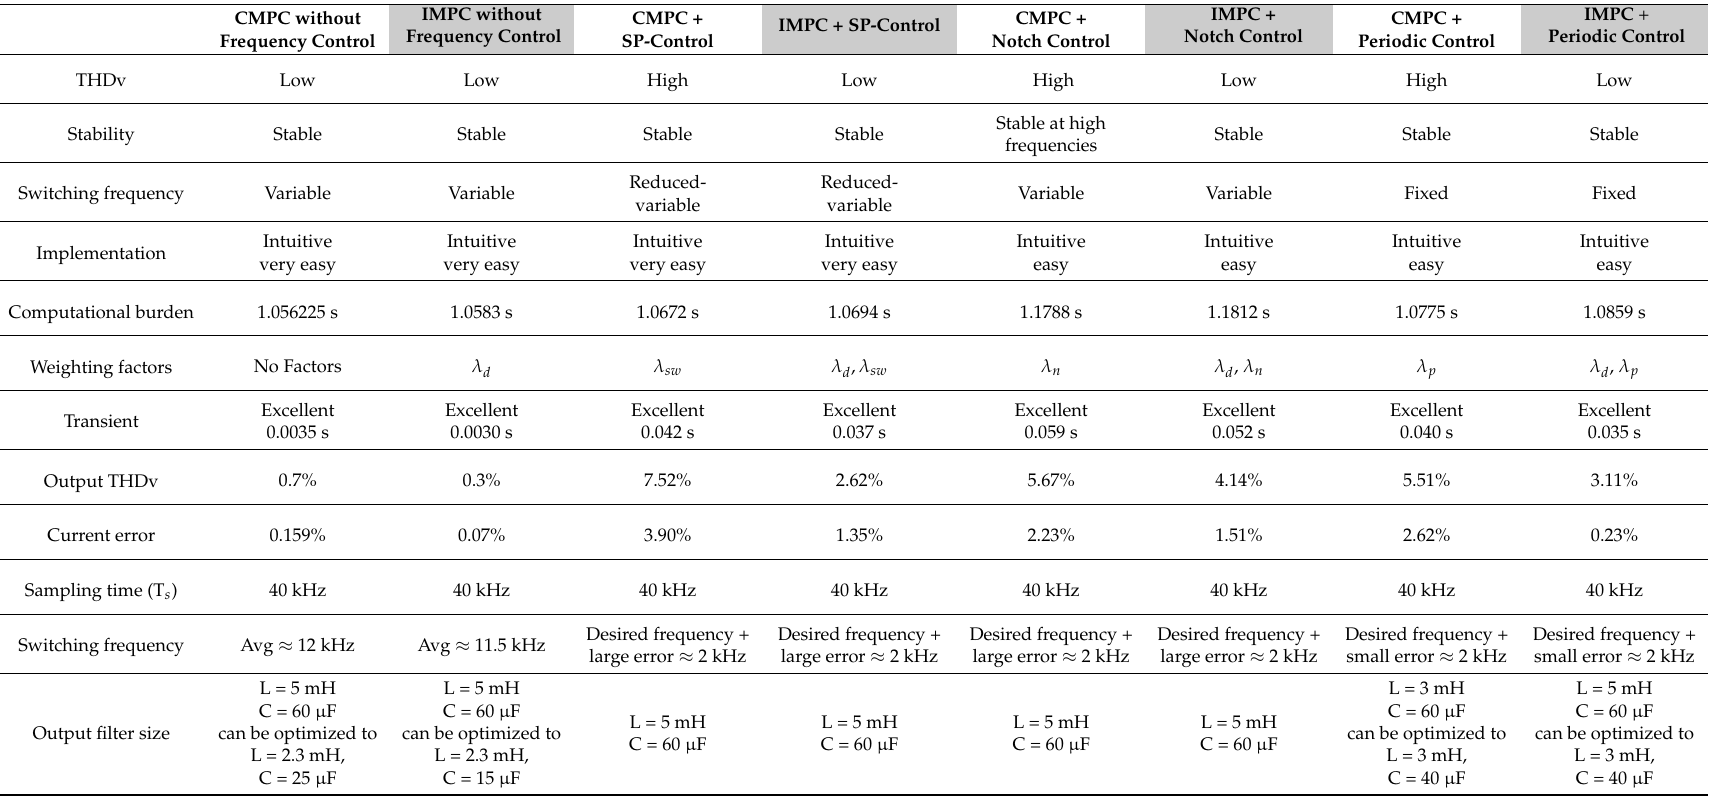
Table 3. Characteristics of the implemented conventional and proposed MPC